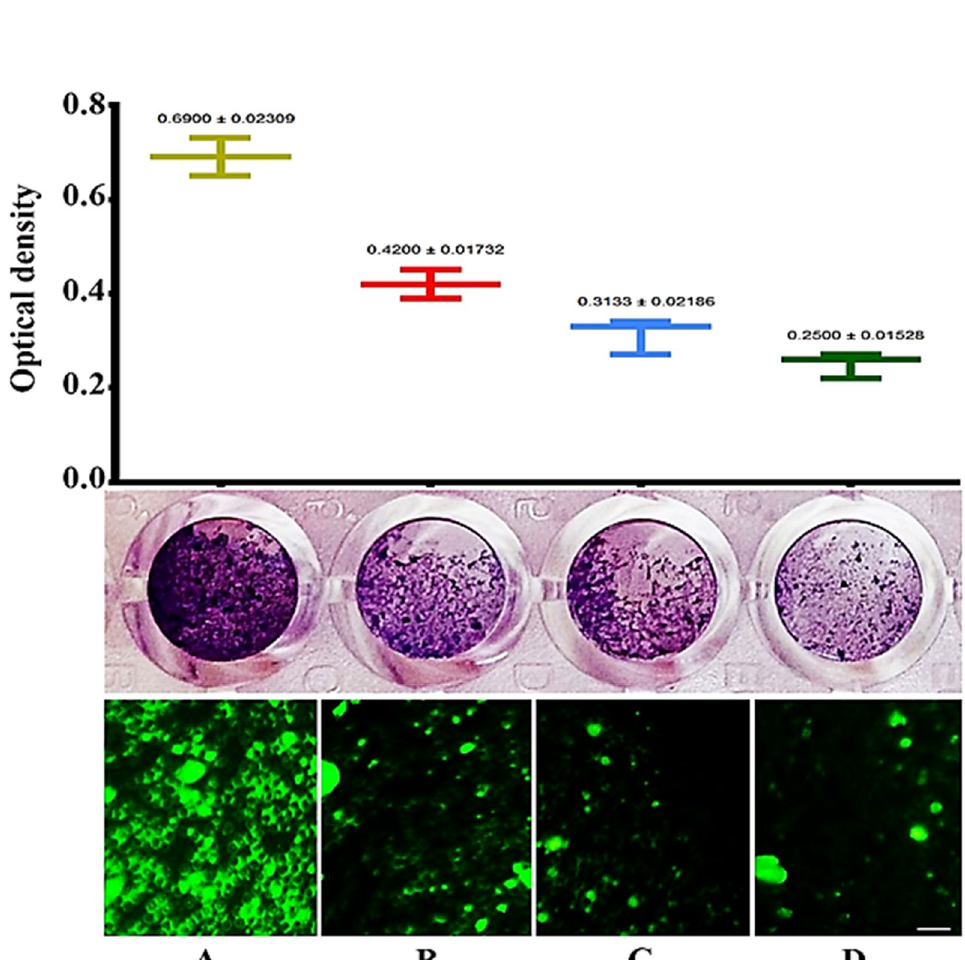
Figure 10. SWCNTs decorated with ZnO–Ag and ZnO–Au reduce E. coli biofilm formation. The upper panel represents the quantification of biofilm formation as determined by crystal violet staining. The lower panel shows fluorescence microscopy images. A nucleic acid stain was used. The scale bars represent 10 µm. ( A ) Untreated control E. coli . ( B ) E. coli treated with functionalized SWCNTs. ( C ) E. coli treated with ZnO– Ag-SWCNTs. ( D ) E. coli treated with